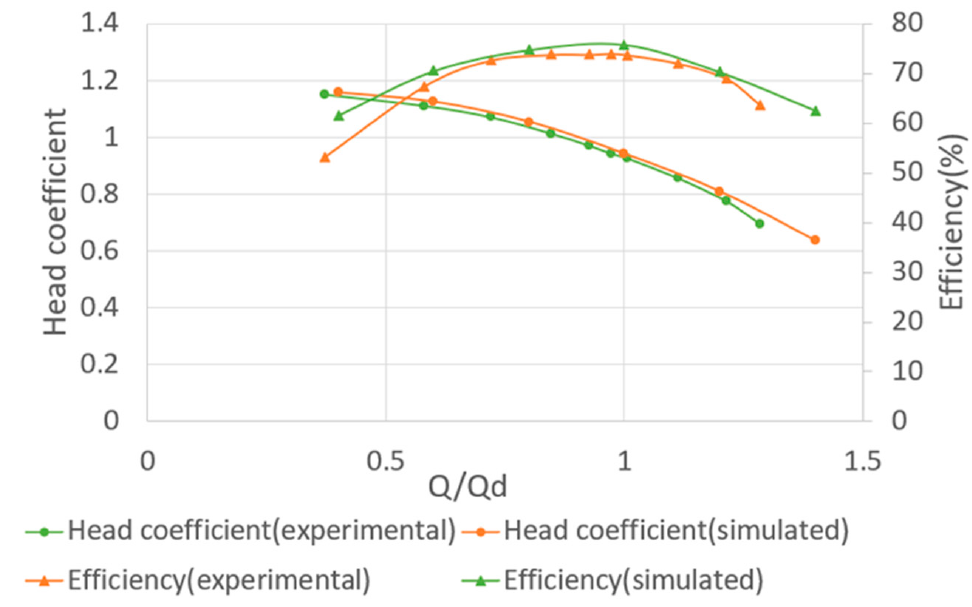
Figure 3. Performance comparison between numerical and experimental results.